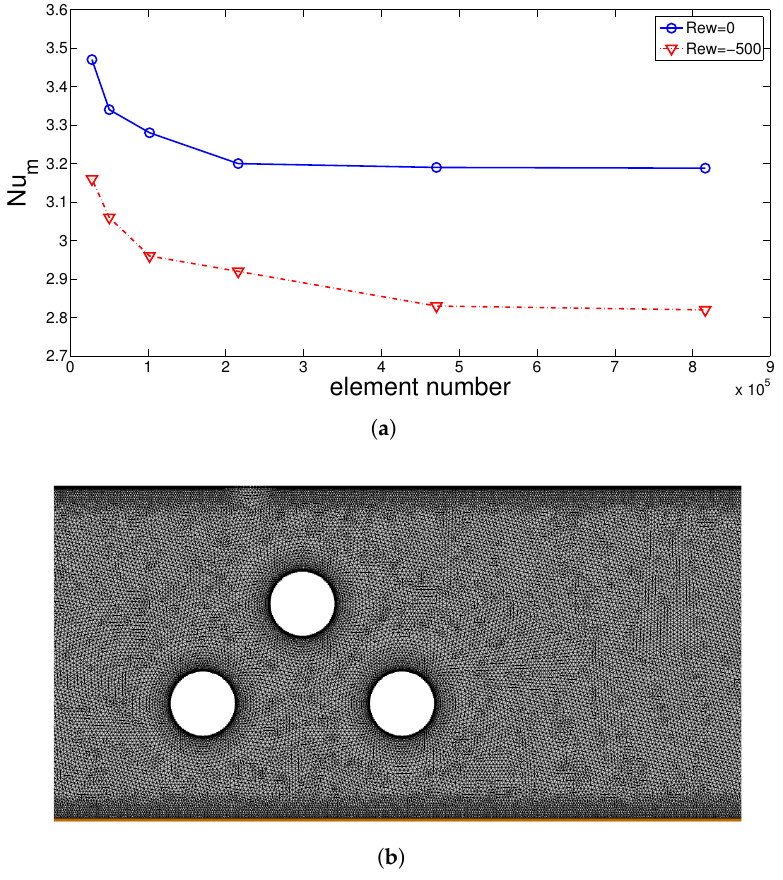
Figure 3. Test results for grid independence: Average Nu for different grid sizes considering rotating and non-rotating CCs ( a ) (Ha = 5, Mx = − 1) and grid distribution near the CCs ( b